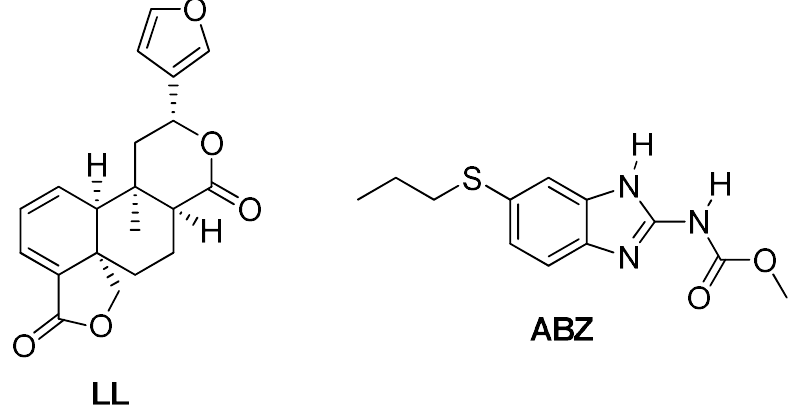
Figure 1. Structure of linearolactone ( LL ) and albendazole ( ABZ ).